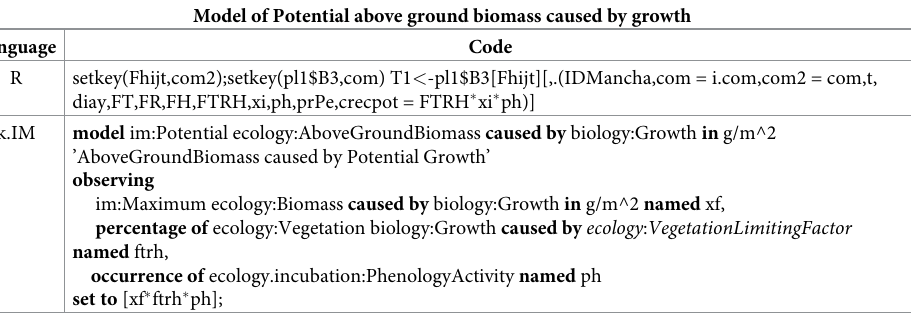
Table 1. Comparison between R and k.IM language for the “Potential above ground biomass caused by growth” model. Model of Potential above ground biomass caused by